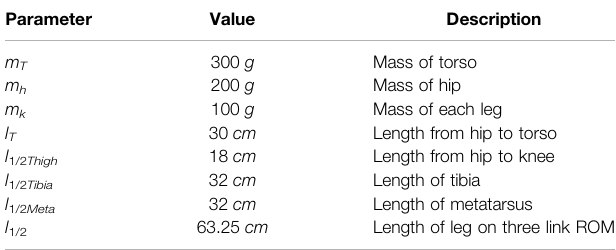
TABLE 1 | Model parameters.